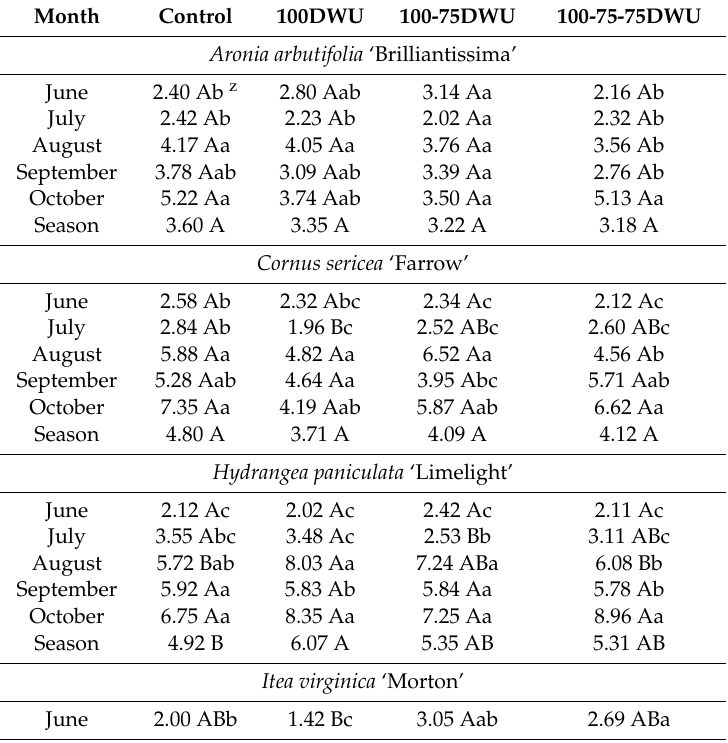
Table 3. Monthly crop coe ffi cient (K C or K Cadj ) for eight shrubs grown in 10.2 L containers under four irrigation treatments z from 11 June (Day 0) through 14 October (Day 126) 2009. Control = 19 mm · application − 1 (1.02 L · day − 1 ); 100DWU = 100% daily water use (DWU) replacement each day; 100-75DWU = 2-day cycle alternating 100% DWU and 75% DWU; and 100-75-75DWU = 3 day